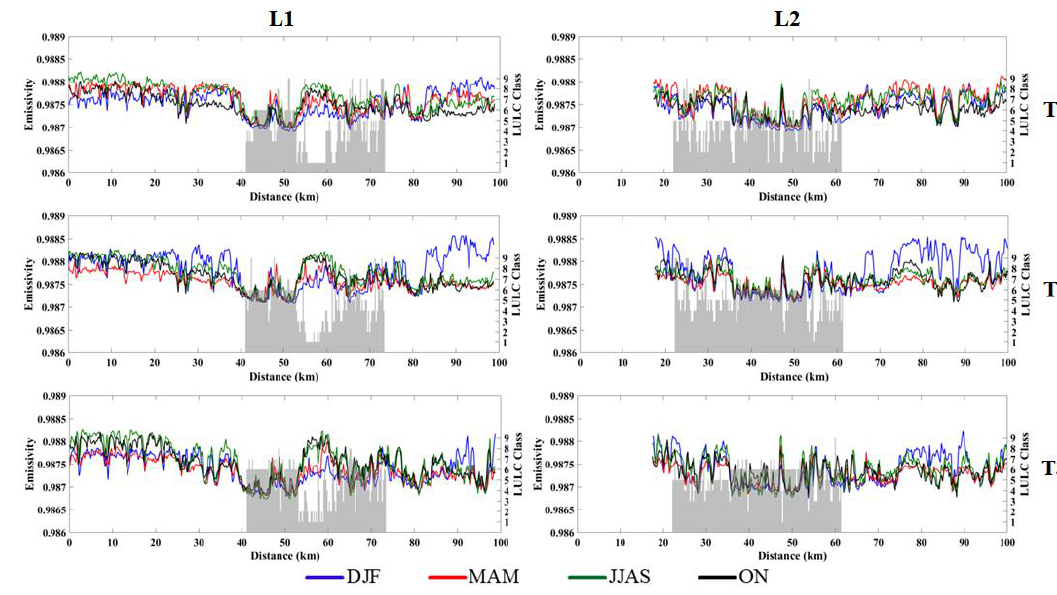
Figure 5. Same as Figure 3, but for emissivity.